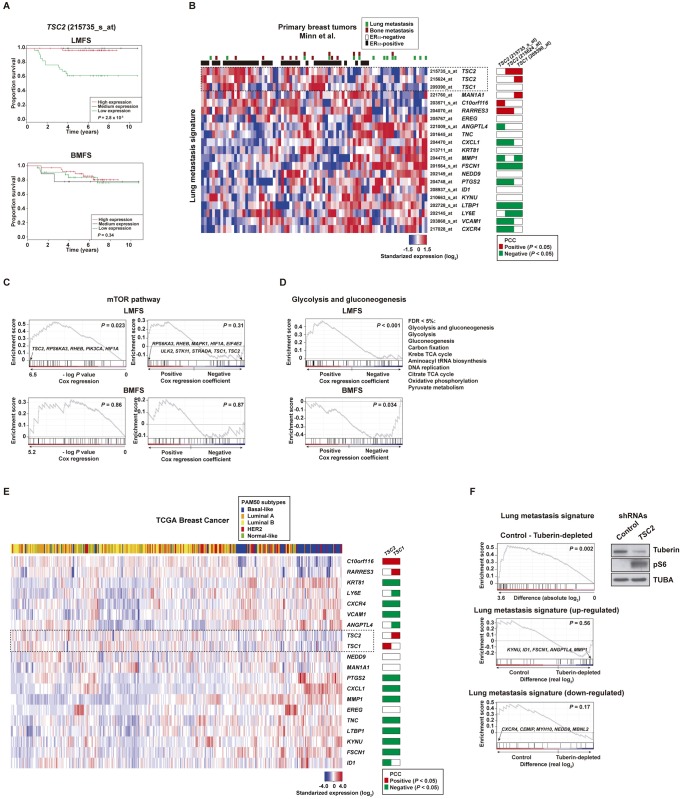
Expression of mTOR pathway components and breast cancer metastasis to lung.(A) Kaplan-Meier lung metastasis-free survival (LMFS) and bone metastasis-free survival (BMFS) curves based on categorization of TSC2 expression. The P values of the Cox proportional-hazards regression analysis are shown. (B) Tumor sample and gene expression clustering, and correlations of TSC1/2 and genes from the lung metastasis signature, in the seminal breast cancer dataset [27]. (C) GSEA results for Cox regression values of the mTOR pathway gene set and LMFS or BMFS. (D) GSEA results for Cox regression values of metabolic pathway gene sets and LMFS or BMFS. (E) Tumor sample and gene expression clustering, and correlations between TSC1/2 and genes from lung metastasis signature, in the TCGA dataset [70]. (F) GSEA results for the expression difference of the lung metastasis signature between MCF7 cells transduced with control or TSC2-target shRNAs. The left top panel shows the results for absolute expression differences, and the middle and bottom panels show the results for real differences of the up-regulated and down-regulated subsets of the signature, respectively. The right panels show the Western blot results for tuberin, pS6 and control loading, TUBA.